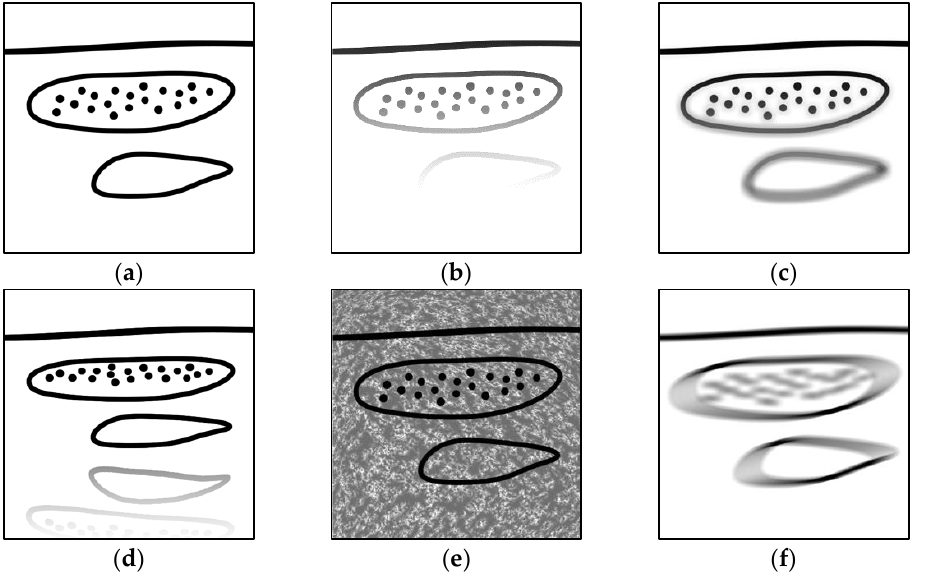
Figure 4. Image domain manifestations of limitations in tissue and in the acquisition process. The upper thick line represents the skin boundary. The shapes below represent optoacoustic absorbers in tissue. ( a ) Original, unaffected image. ( b ) Reduced contrast at depth due to optical attenuation. ( c ) Reduced resolution of deeper structures due to acoustic attenuation. ( d ) Reflection artifacts due to acoustic heterogeneity. ( e ) Clutter originating from optical absorbers outside the imaging plane. ( f ) Directional blurring due to motion.